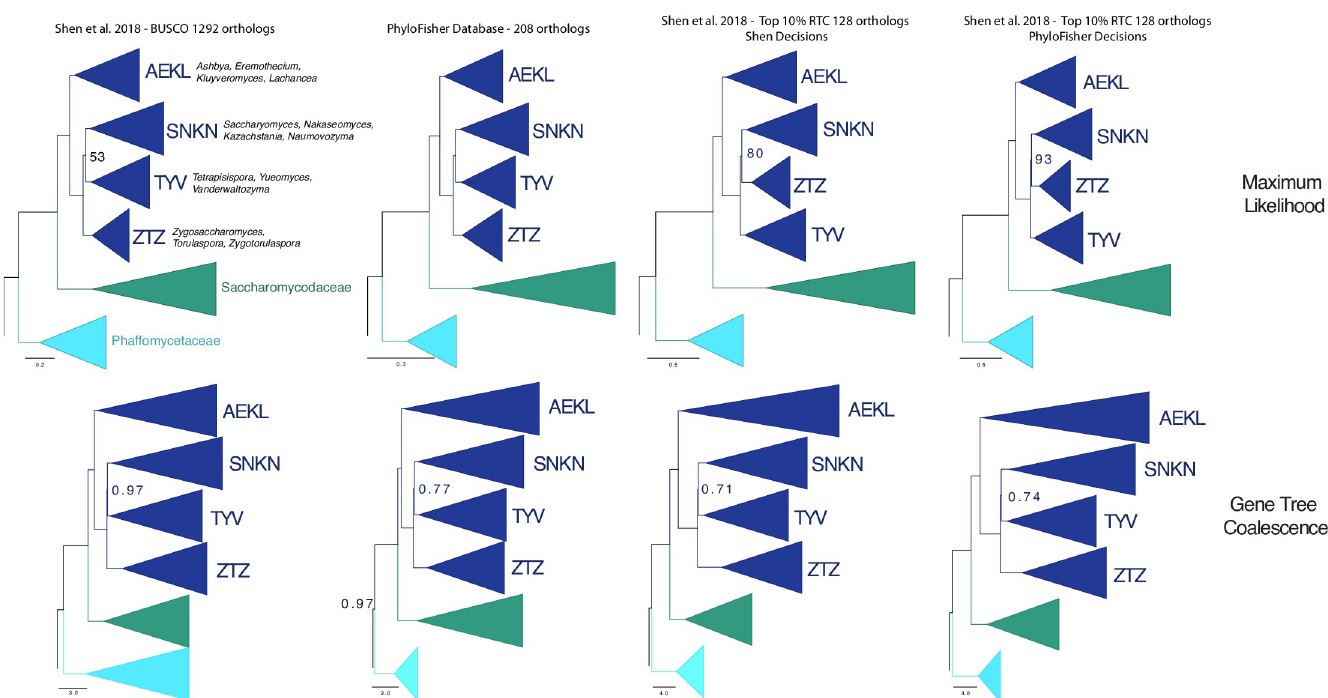
Fig 4. Phylogenetic reconstruction of the tree of Saccharomycetaceae using 4 different datasets. ML trees (top row) were collected from [20] in A and built using LG+G4+F+C60-PMSF model, with an LG+G4+F+C20 ML tree as a PMSF guide input tree in IQ-TREE v1.6.7.1 [36] for B, C, and D. Gene tree coalescence trees (bottom row) were collected from [20] in A and built using astral_runner . py , which employs ASTRAL-III [9]. The corresponding dataset a column of trees is derived from is shown across the top of the figure. Sub-clades that make up the Saccharomycetaceae are shown in dark blue (comprised of AEKL, SNKN, TYV, and ZTZ clades), while the outgroup clades of the Saccharomycodaceae and the Phaffomycetaceae are shown in dark green and cyan, respectively (labeled S and P, respectively). To the right of each Saccharomycetaceae clade is an abbreviation made up of the first letter of each genus included in the clade. Full genus names are written out to the right of the upper left ML tree. Nodes are maximally supported (100 MLBS or 1.0 LPP) unless otherwise shown. The full tree of the PhyloFisher 208 dataset is available in the Supporting information (Fig Y in S1 Text). LPP, local posterior probability; ML, maximum likelihood; MLBS, maximum likelihood bootstrap support; PMSF, posterior mean site